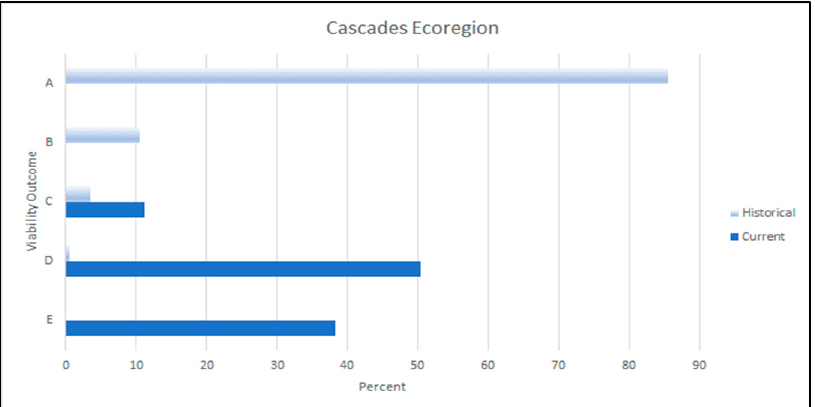
Figure 9. Historical (light blue bars) and current (dark blue bars) viability outcomes for red tree voles ( Arborimus longicaudus ) in the Cascades ecoregion in Oregon, USA. Viability outcomes are described in Table 4.